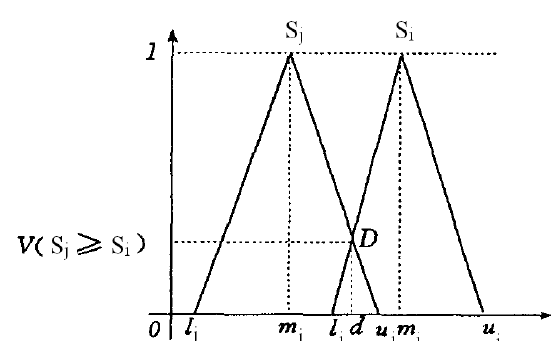
Fig. 4. Highest intersection point D between µS